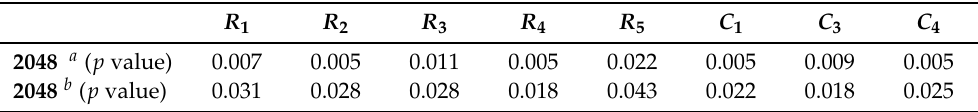
Table 5. Results of Wilcoxon signed-rank test for the original and refactored codes ( H 0 : p > 0.05, H 1 : p < 0.05).